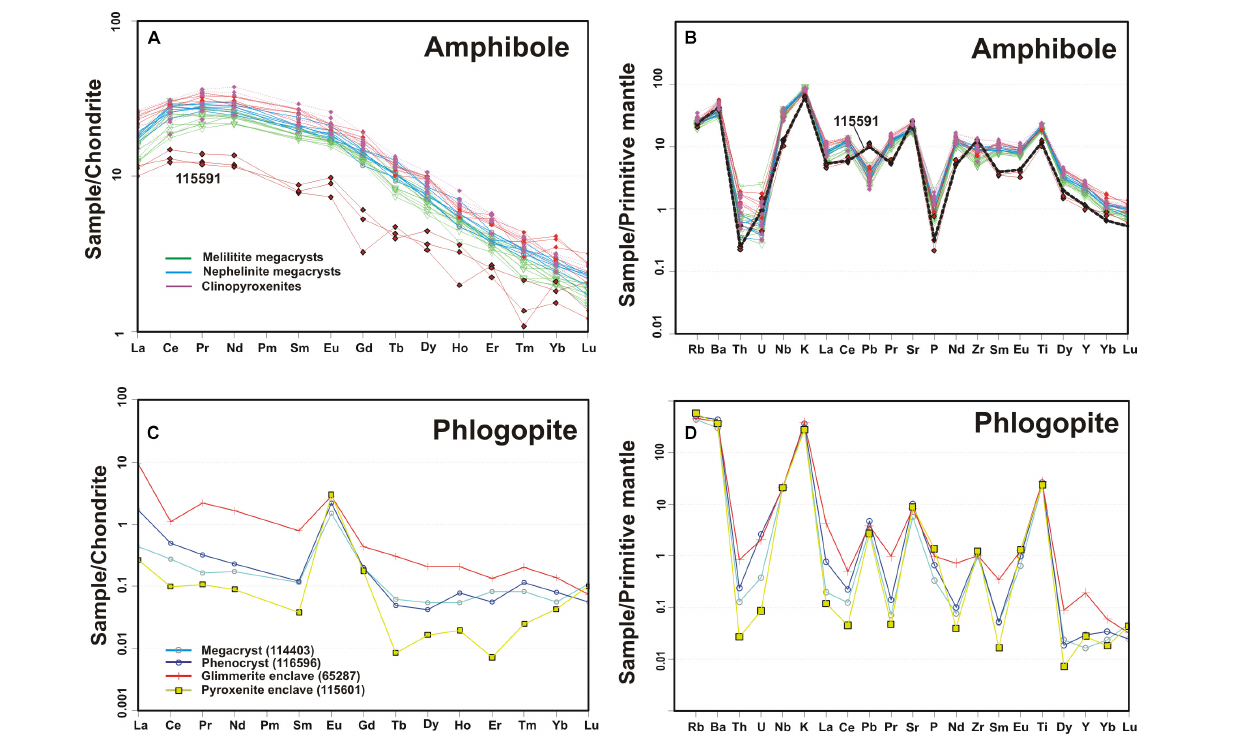
FIGURE 8 | REE and multi-element patterns of amphibole (A,B) and phlogopite (C,D) . Amphibole megacrysts are from El Aprisco melilitite (115603, 114404) and from the Cerro Pelado nephelinite (111653); amphibole from clinopyroxenite enclaves comes from samples 115601 and 116598. Amphibole from pyroxenite 115591 has low REE contents (A) , and its average is highlighted in panel (B) , showing marked Pb and Zr positive anomalies. Phlogopite patterns in panel (C,D) are averaged values. Mineral chemical data from Supplementary Table S3 . Chondrite and primitive mantle normalizing values are from Boynton (1985) and Sun and McDonough (1989),